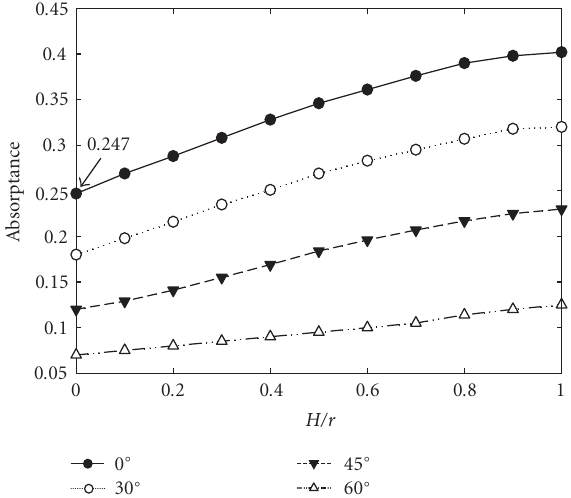
Figure 4: The relation among absorptance, distance and photon’s incidence angle θ .